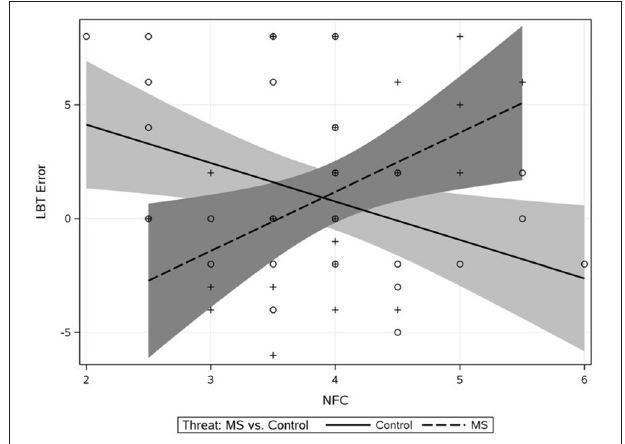
FIGURE 2 | Study 1 effect of threat × NFC interaction on LBT bisection errors. Shaded regions represent 95% confidence bands on the regression lines. Positive values indicate leftward bisection